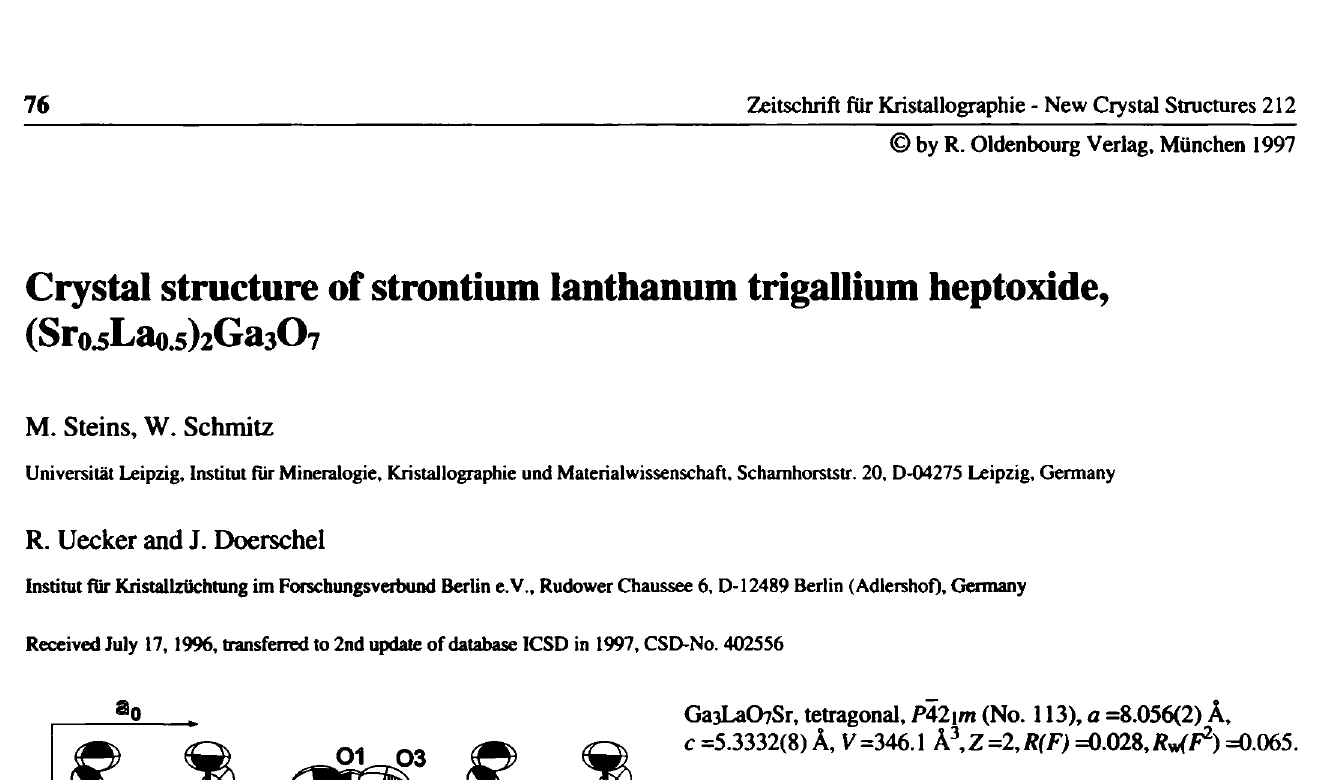
Table 1. Parameters used for the X-ray data collection